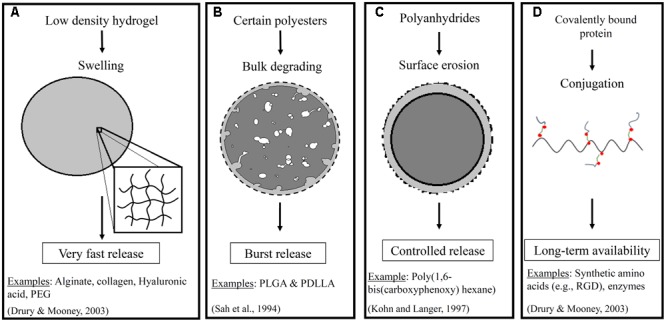
Illustrates a few important properties of scaffolds that impact drug release. These include (A) swelling of low density hydrogels, (B) bulk degrading polyesters, (C) surface erosion in polymers such as polyanhydrides in an aqueous environment, and (D) covalent conjugation of proteins. The resulting impact on the release profiles including very fast, burst, controlled, and extended or long term availability, respectively, for a representative pharmaceutical agent. The dashed line represents the initial boundary of the material (Sah et al., 1994; Drury and Mooney, 2003; Ratner et al., 2004).